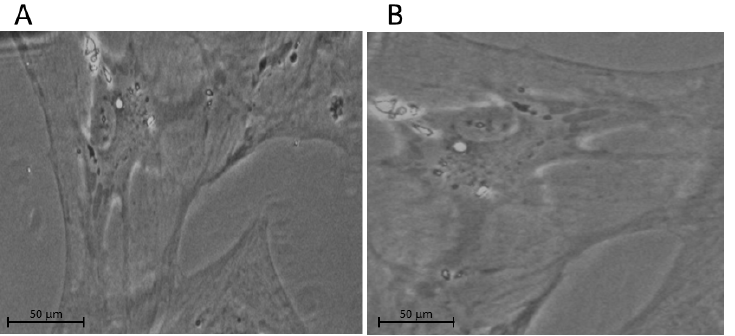
Figure 1. Examples of phase contrast microscopy images of cultured LC cells from ( A ) non- glaucomatous and ( B ) glaucomatous human donors. We note that the glaucomatous LC cell is larger than the non-glaucomatous LC cell.